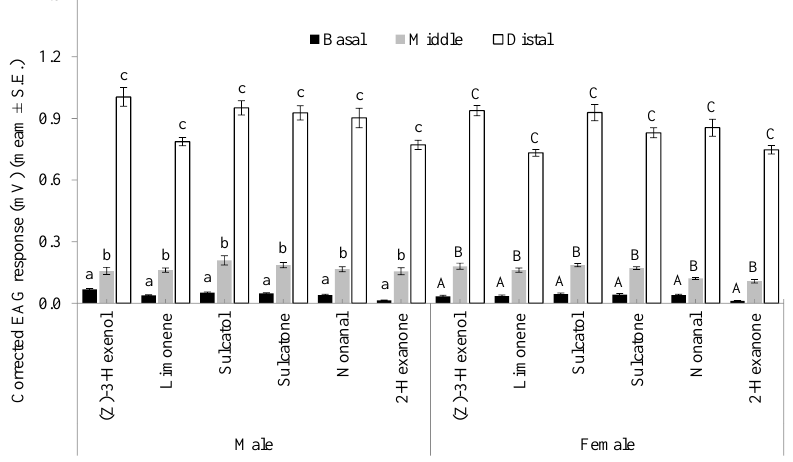
Figure 1. EAG responses of different groups of male and female A. bungii flagellomeres (basal, first to third; middle, fourth to sixth; distal, seventh to ninth) to 1 mg loads of six VOCs.